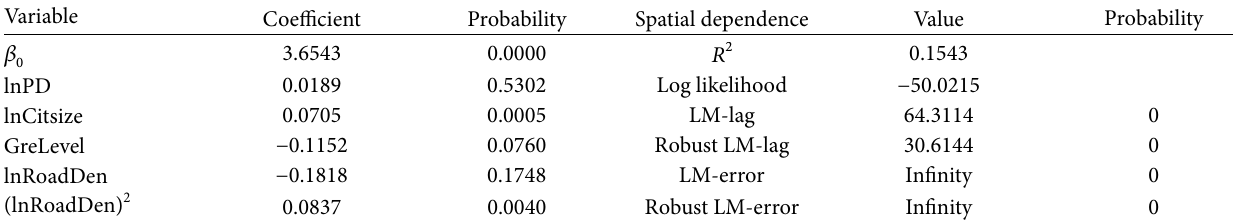
Table 3: Results of the OLS estimation.